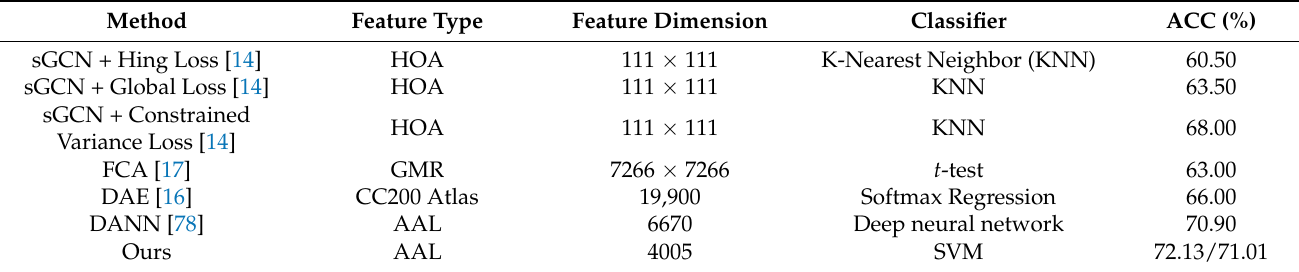
Table 4. Comparison with state-of-the-art methods for ASD identification using rs-fMRI ABIDE data on the NYU site. HOA: Harvard Oxford Atlas. GMR: grey matter ROIs, and AAL: anatomical automatic labelling. CC200: Craddock 200. sGCN: siamese graph convolutional neural network. FCA: functional connectivity analysis. DAE: denoising autoencoder. DANN: deep attention neural